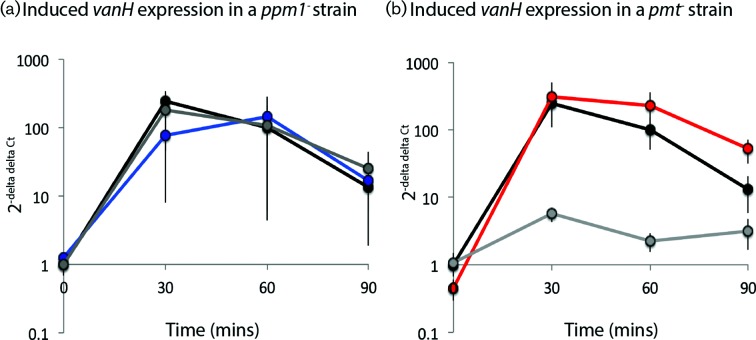
Transcription of vanH in response to vancomycin induction. qRT-PCR was performed to measure relative levels of vanH mRNA following addition of 0.1 µg ml−1 vancomycin to (a) DT3017 (blue; ppm1–) and (b) DT2008 (red; pmt–) strains alongside the parent strain (black;J1929) and their respective complemented strains (grey; panel a; DT3017:pDT16 and panel b; DT2008:pDT10). In each instance hrdB was used as the reference gene and J1929 time-point 0 as the reference sample.